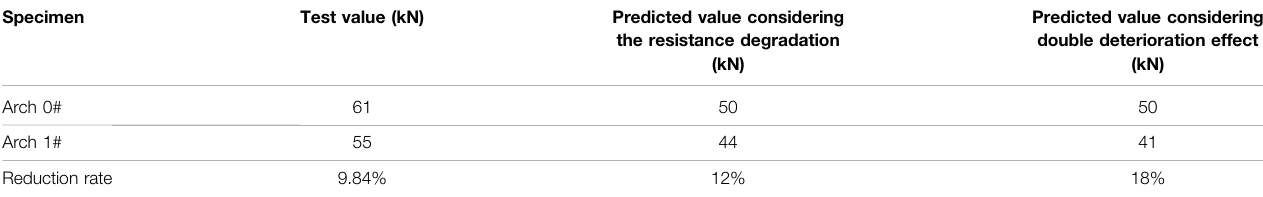
TABLE 2 | Bearing capacity of the arch